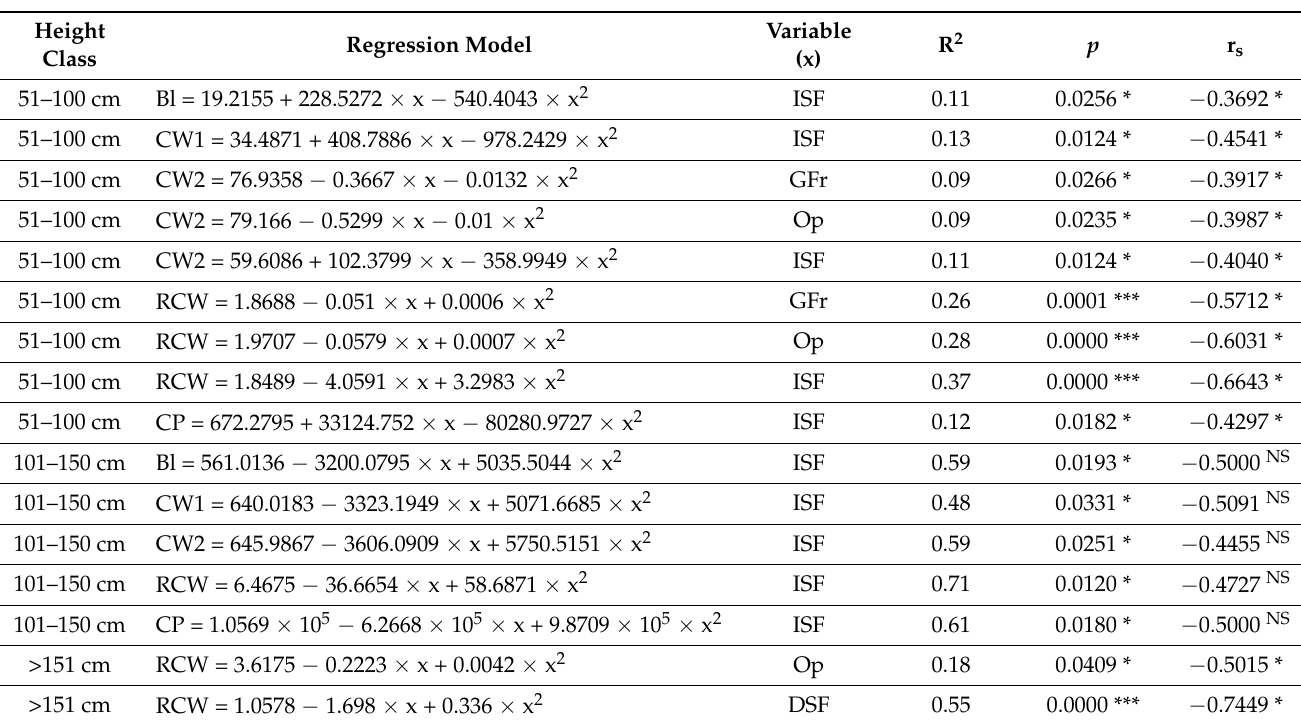
Table A3. Significantly proved regression models of light intensities and morphological param- eters and indexes expressing lateral growth of Norway spruce natural regeneration under size- dependent